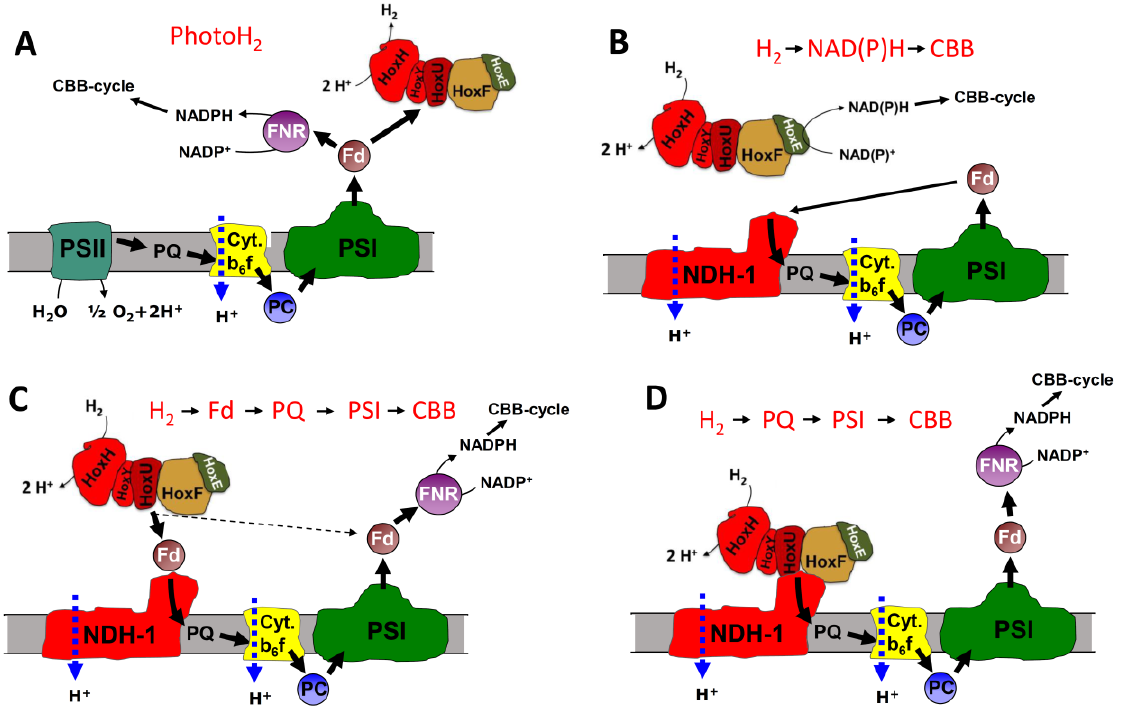
Figure 1. Schematic showing the different electron transport routes discussed. ( A ) Under anaerobic conditions when the CBB cycle is not activated the hydrogenase acts as an electron valve and produces photoH 2 when photosynthesis starts from darkness. Because of PSII forming O 2 , conditions turn more oxidizing after a short time and H 2 evolution turns into hydrogen uptake (for an example see Figure 3). The electrons gained from H 2 oxidation could follow three different routes. ( B ) The hydrogenase could directly reduce NADPH, which would than serve the CBB cycle while cyclic electron transport provides the necessary ATP. ( C ) In an alternative pathway H 2 oxidation could result in ferredoxin reduction that is then re-oxidized by the photosynthetic NDH-1 complex. ( D ) In the third option, the hydrogenase could be part of the NDH-1 complex and deliver the electrons directly to the PQ pool. Abbreviations: Fd = ferredoxin, FNR = ferredoxin NADP reductase, PSII and